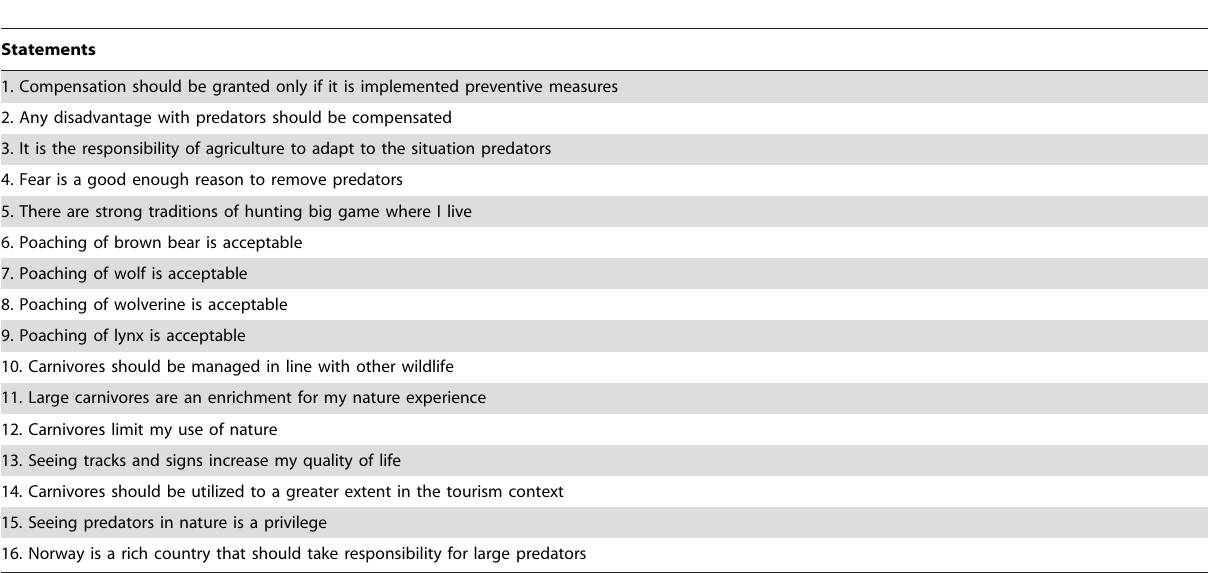
Table 1. The questionnaire (16 questions in total) including the questions dealing with acceptance of illegal hunting (question 6–